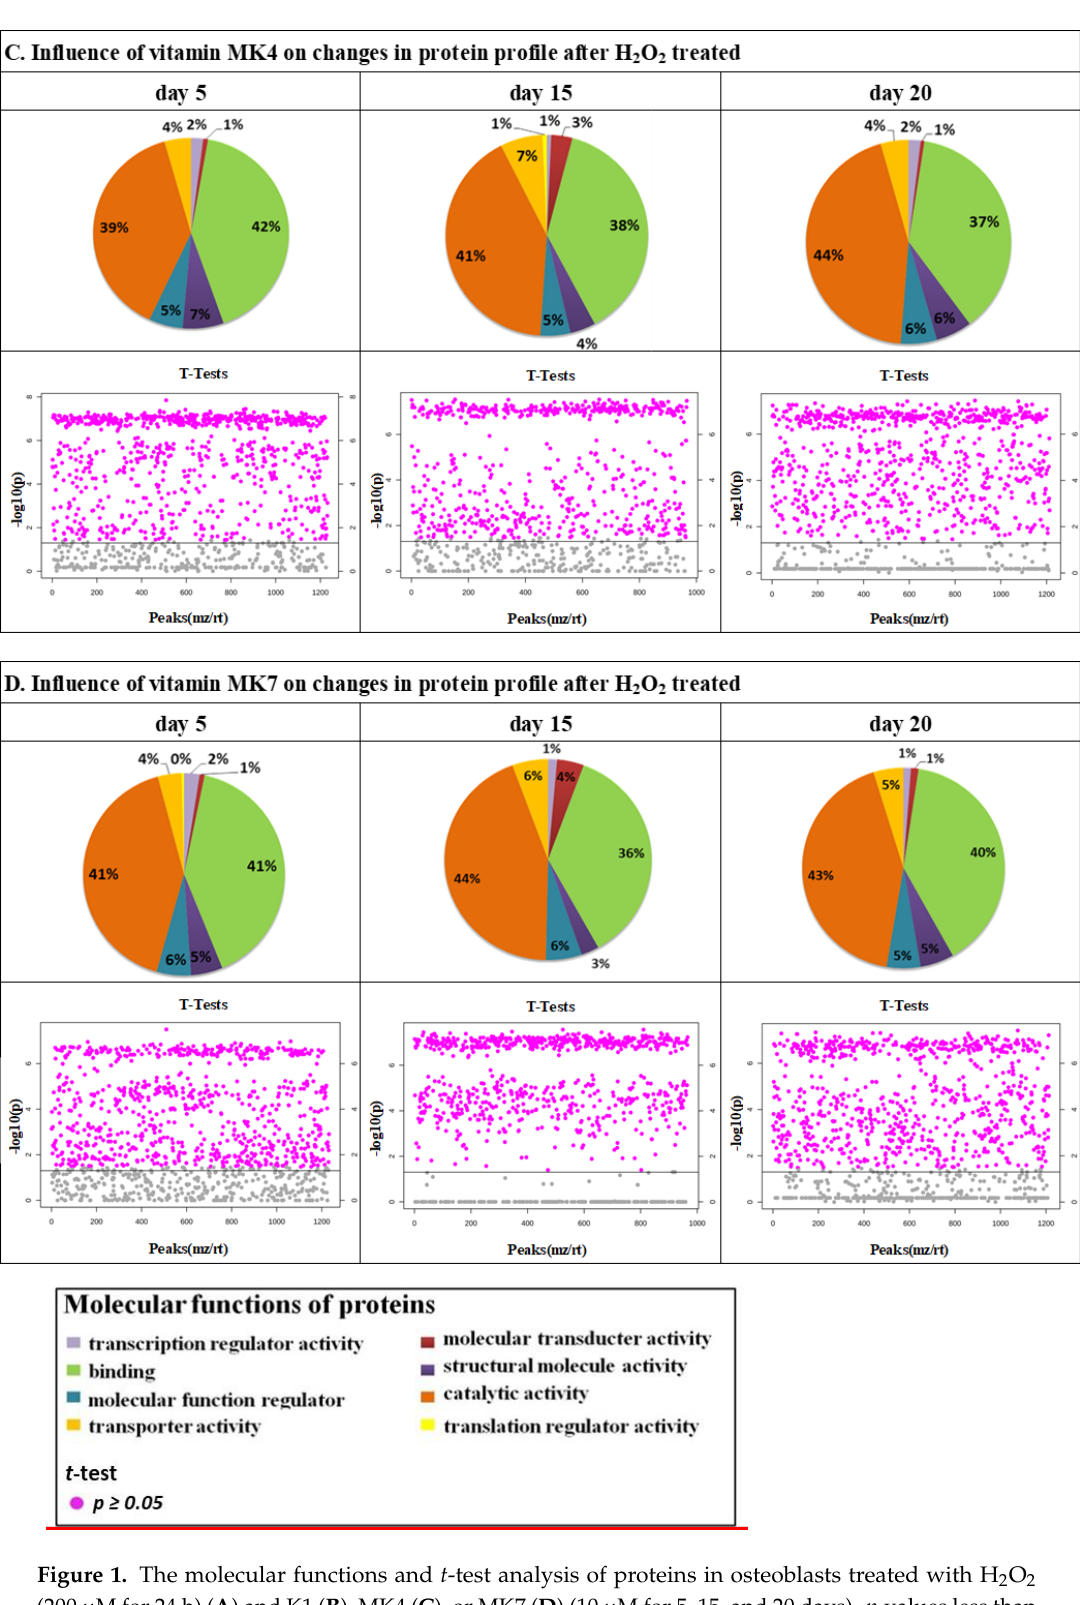
Figure 1. The molecular functions and t -test analysis of proteins in osteoblasts treated with H 2 O 2 (200 µ M for 24 h) ( A ) and K1 ( B ), MK4 ( C ), or MK7 ( D ) (10 µ M for 5, 15, and 20 days). p -values less than 0.05 were considered statistically significant. p -values presented on figure are included in Table